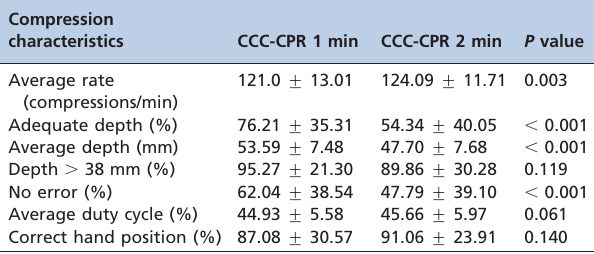
Table 2 - Chest compression continuously performed for one and two minutes.